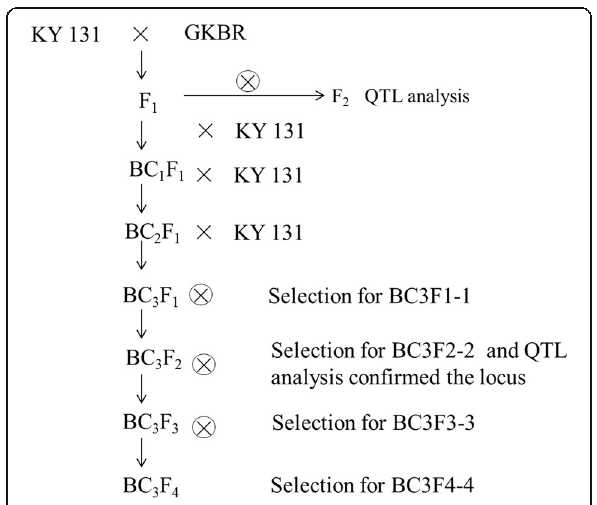
Fig. 7 Procedure of selection for the improved line BC3F4 – 4